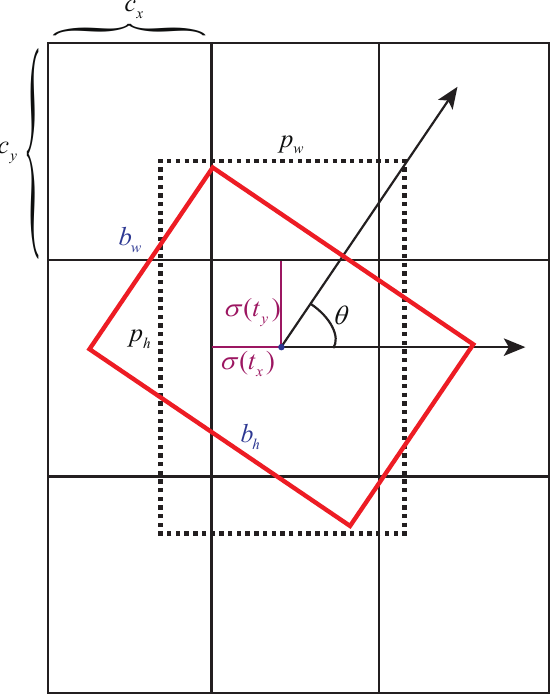
Figure 3. The sloping anchor